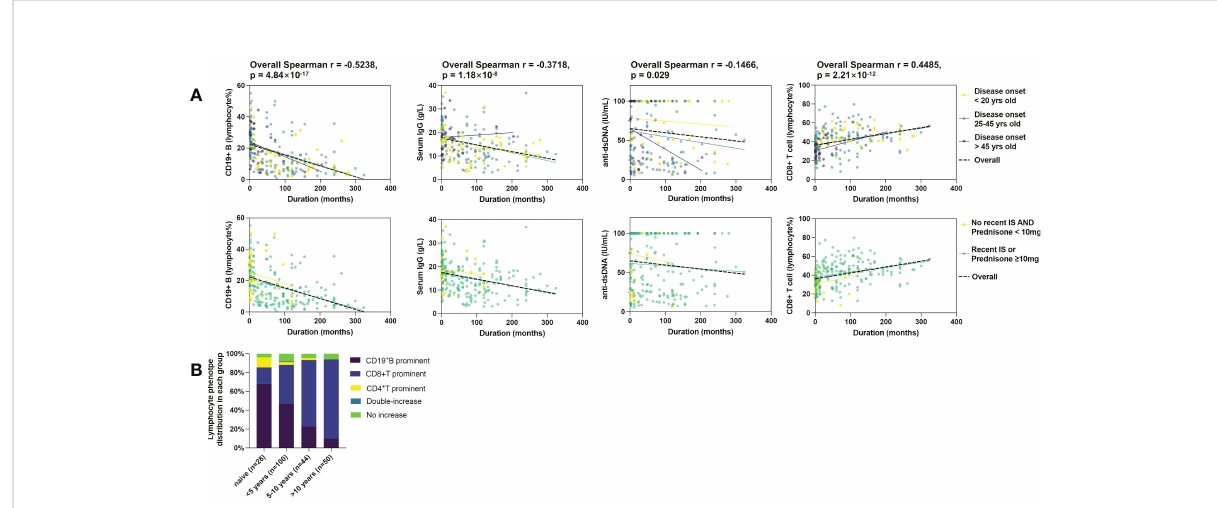
FIGURE 3 Correlation of immunological phenotypes of active SLE with disease duration. 222 cases were included. (A) Correlation of B cell%, serum IgG, serum anti-dsDNA, and CD8+ T cell% with disease duration. The black lines represent fi t plots for the whole study population (n=222), and colored lines represent fi t plots for subgroups by disease onset age (top) or recent treatment (bottom). (B) Duration biased distribution of lymphocyte balance in active SLE. The de fi nition of lymphocyte types is shown in Supplementary Table 5.